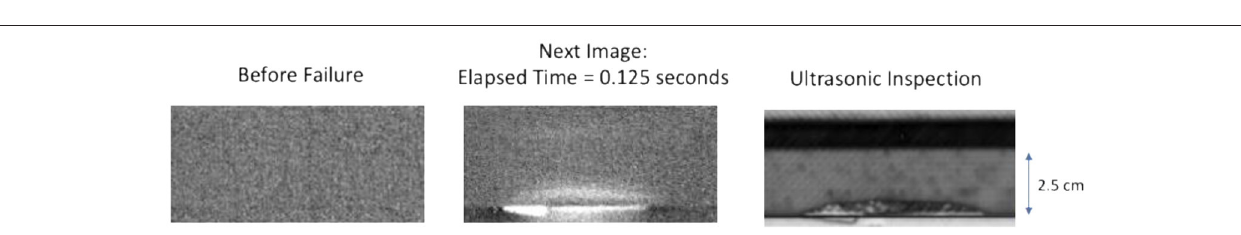
FIGURE 3 | Comparison of instantaneous heating image to ultrasonic inspection for small